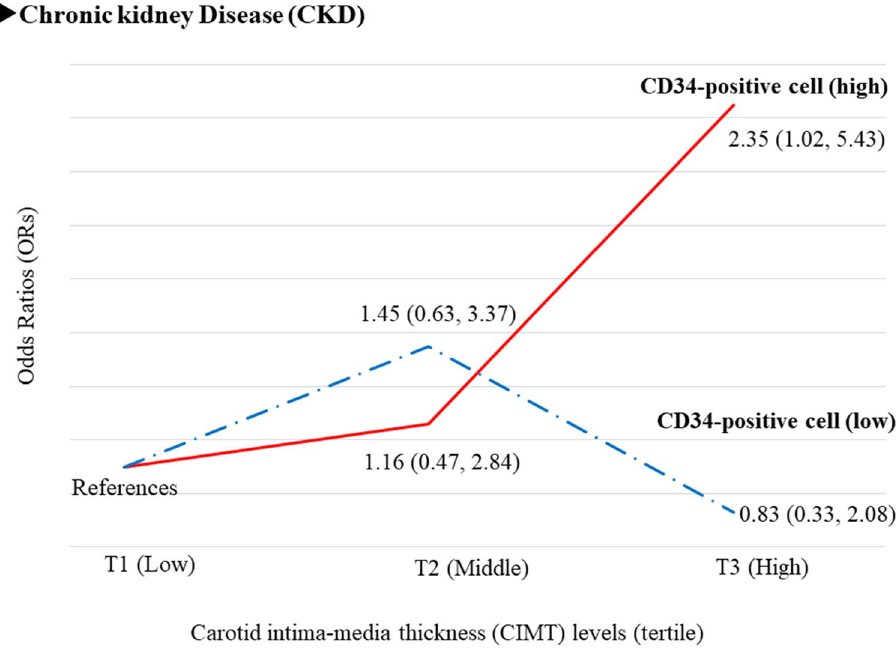
Figure 4. Association between carotid intima-media thickness (CIMT) and chronic kidney disease (CKD) 25 . T1:The lowest tertile level. T2: Middle tertile level, T3: The highest tertile